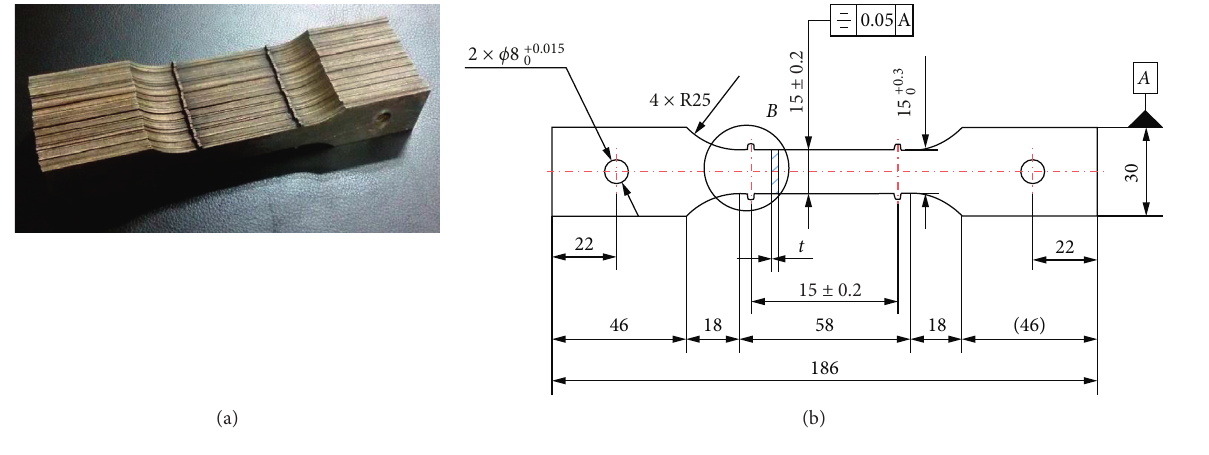
Figure 2: Test specimens and dimensions.